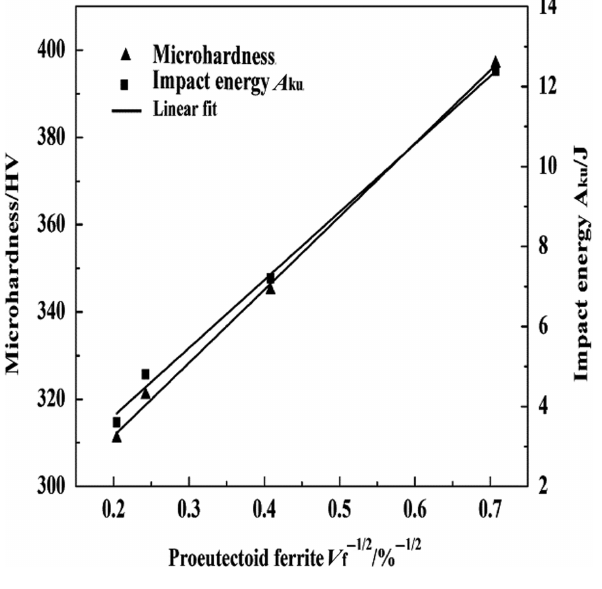
Figure 7: Effect of proeutectoid ferrite on impact energy and microhardness.